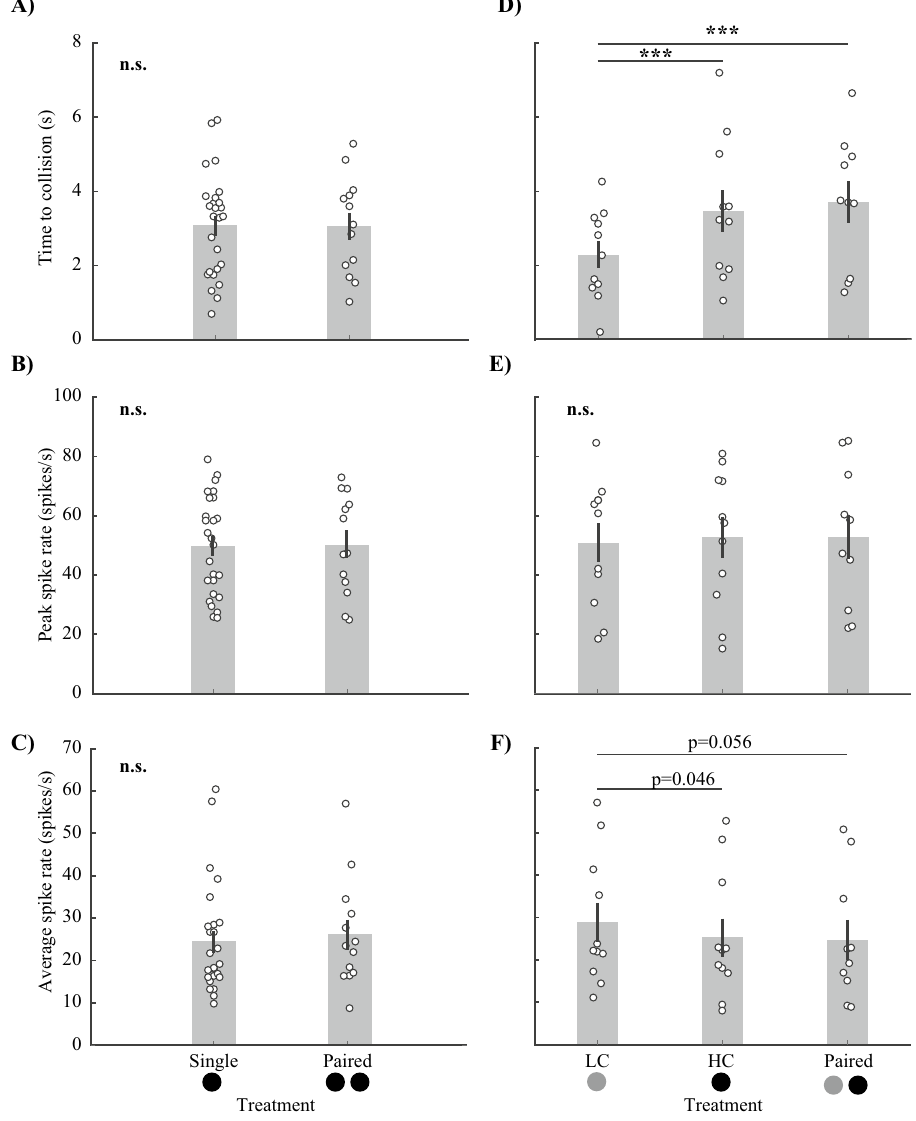
Figure 7. The firing parameters of MLG2 neurons in response to single and paired looming stimuli. ( A – C ) Experiment 1, stimuli of equal contrast; ( D – F ) Experiment 2, stimuli of different contrasts. When all stimuli had the same contrast, there were no differences in ( A ) the time of response, ( B ) peak spike rate, and ( C ) average spike rate, regardless of the number of stimuli that approached. ( D ) When the stimuli had unequal contrasts, MLG2 neurons responded significantly earlier to the single high contrast (HC) or Paired stimuli compared to the single low contrast (LC) stimulus. However, the response timing to the single HC stimulus was similar to that of the Paired stimulus. ( E ) There were no significant differences for the peak spike rate between either the single or paired stimuli of varying contrasts. ( F ) Average spike rate during the response to the single LC stimuli was higher than to the single HC stimulus and the Paired stimulus. However, the result was just not significant when comparing single LC with Paired stimulus. All bars represent means (± SE) and white circles show individual observations. The solid black line and asterisk symbols connect levels of treatments that were found to be significantly different through pair-wise testing (*0.01 < p < 0.05, **p < 0.01, ***p < 0.001, n.s. = not significant). The statistical tests that were performed on transformed data were back transformed for